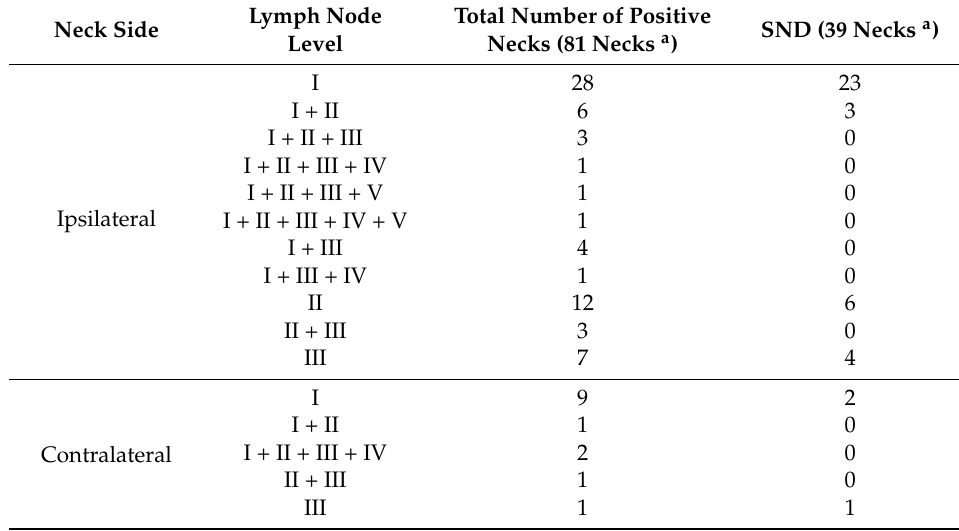
Table 2. Level of lymph node involvement in 68 patients with pN+ and 35 pN+ who underwent SND. Lymph Node Neck Side